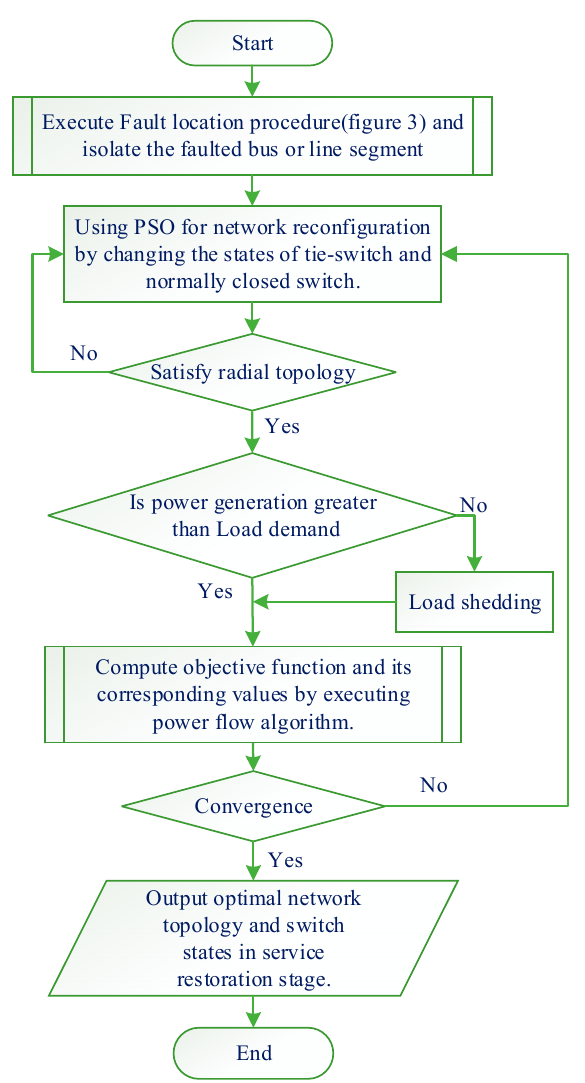
Figure 4. Proposed service restoration algorithm of the MG.